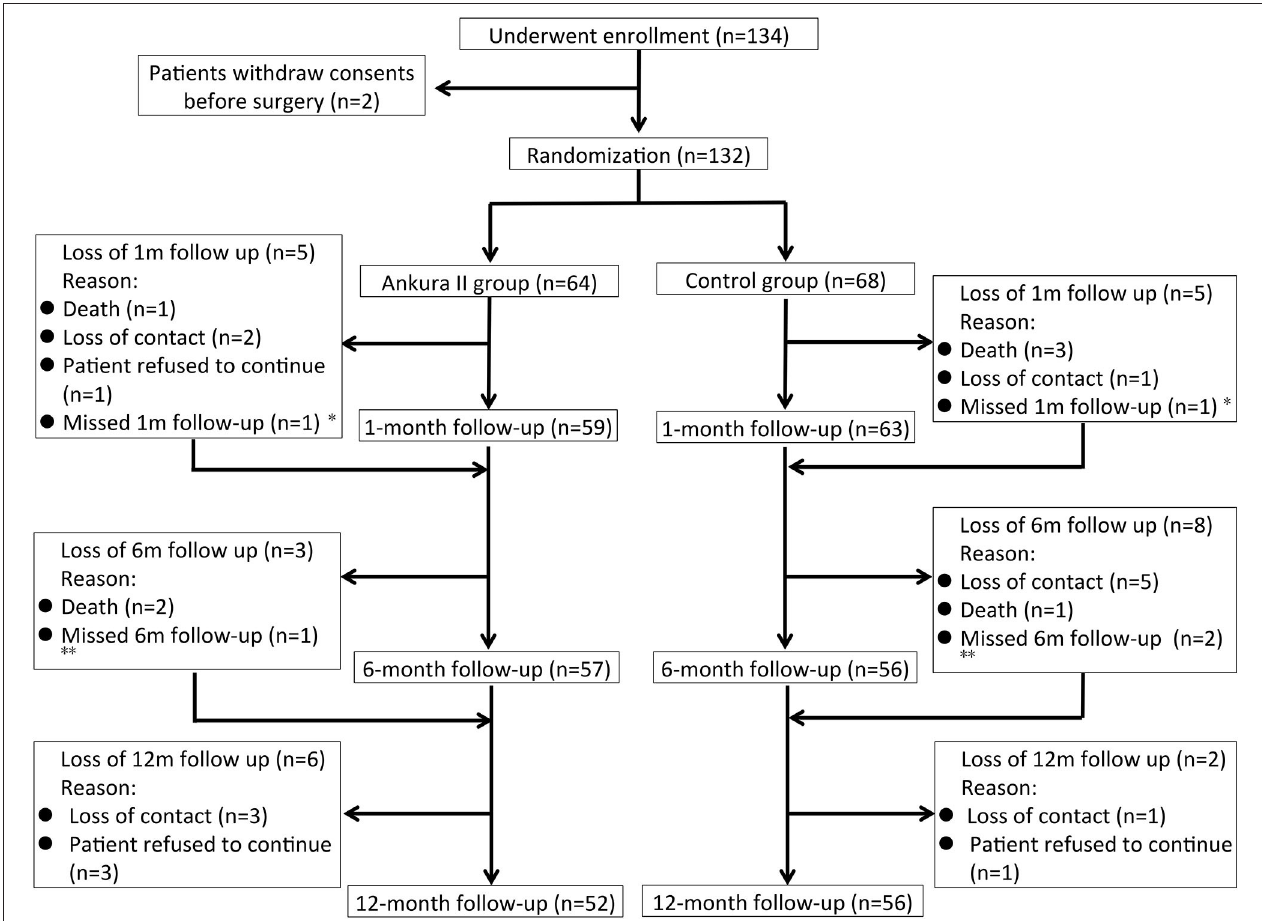
FIGURE 2 | Illustration of the study cohort and the follow-up process. * Ankura II group Patient No. 11 and Ankura group Patient No. 129 missed the 1-month follow-up but finished the 6- and 12-month follow-ups. ** Ankura II group Patient No. 117 and Ankura group Patient No. 50 and No. 120 missed the 6-month follow-up but finished the 12-month